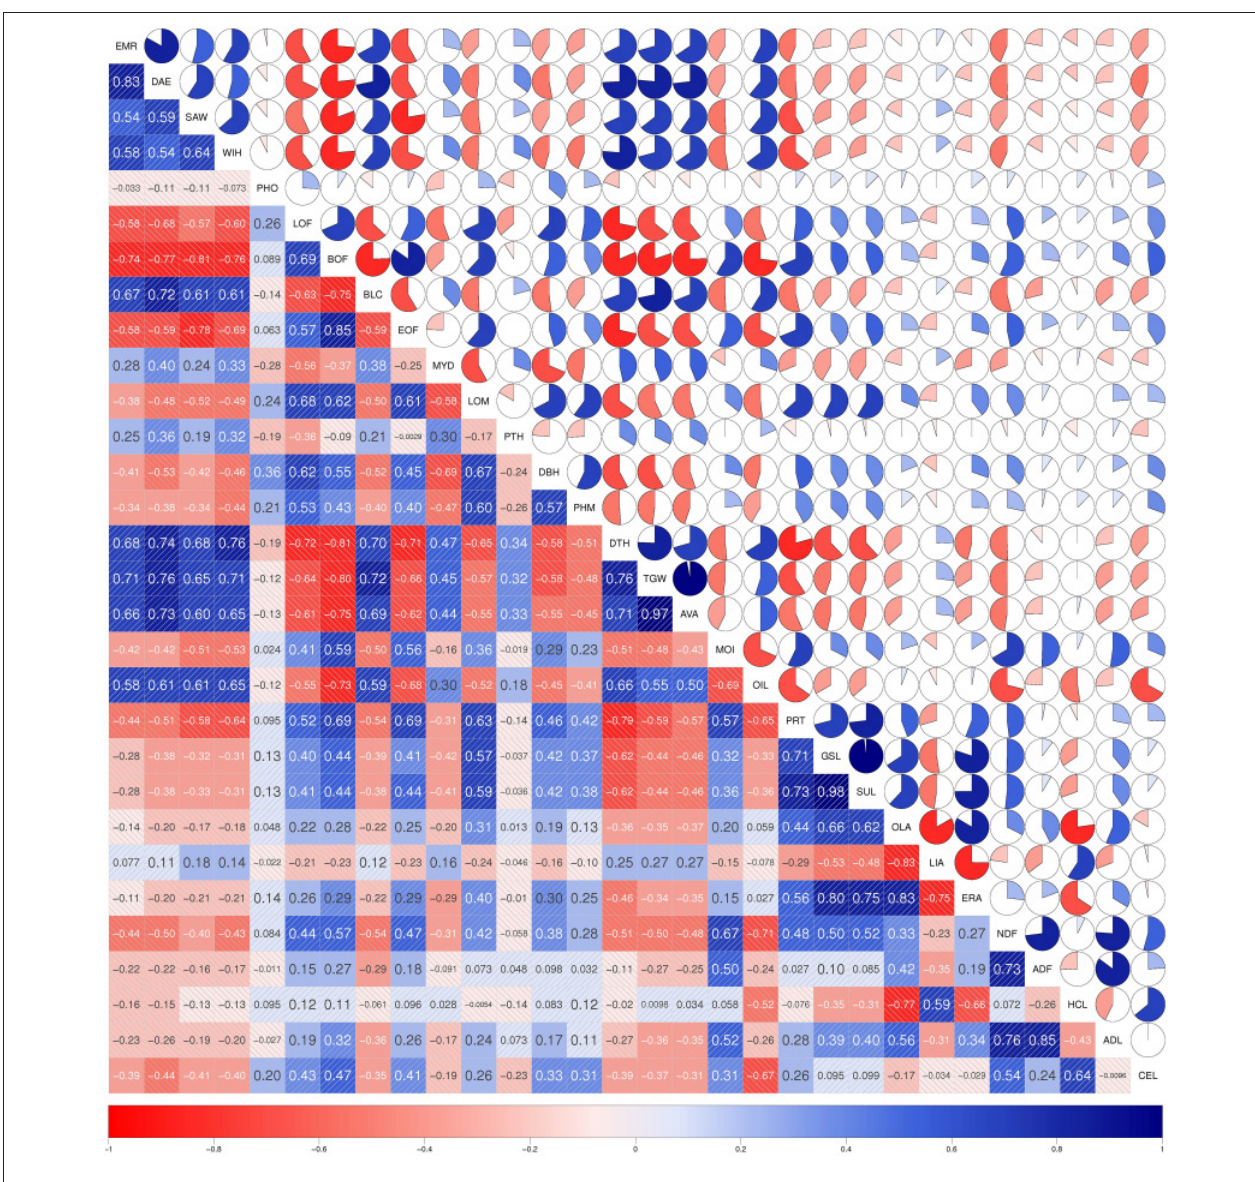
FIGURE 7 | Correlations of the agronomic and seed quality traits across the 217 inbreds of the winter trial. In the diagonal panel the traits are listed. In the upper panel the filled portion of the pie and in the lower panel the depth of the shading as well as the font size indicate the magnitude of the correlations. Negative correlations are colored red and positive correlations